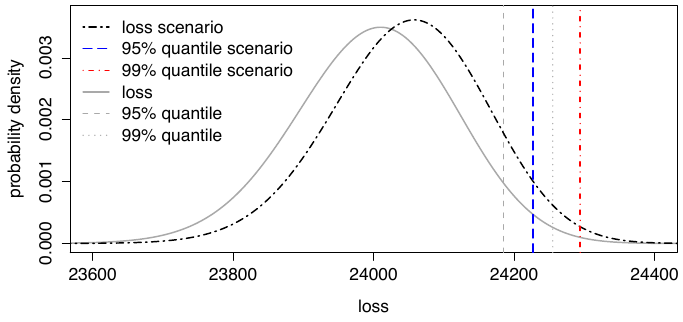
Figure 4. Loss distributions of L and L scen with 95 and 99%